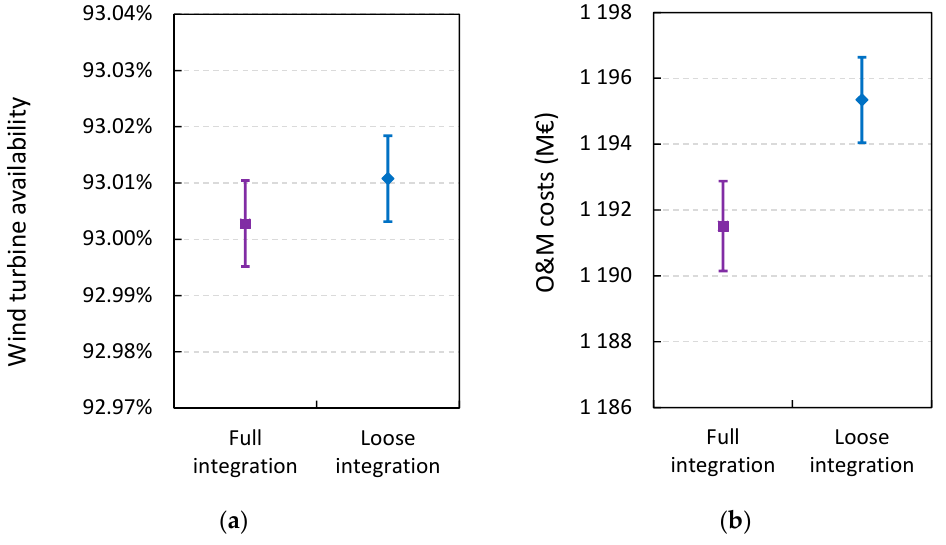
Figure 8. Results for a failure data set that includes all wind turbine components: ( a ) average time-based wind turbine availability; ( b ) O&M costs.